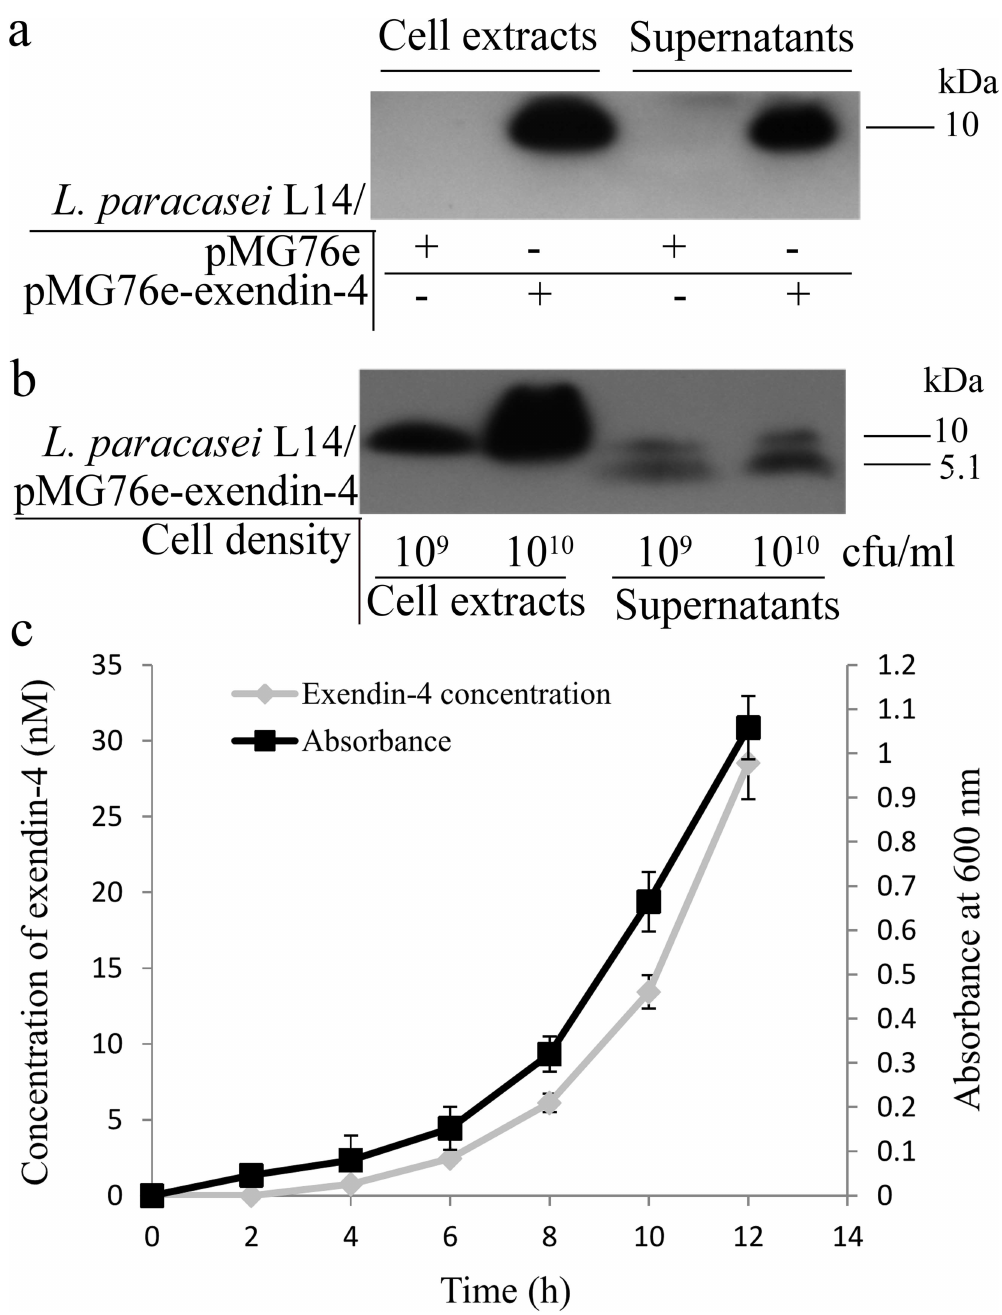
Fig 2. Western blotting and enzyme-linked immunosorbent assay (ELISA) analysis of recombinant exendin-4 produced by plasmid-transformed L . paracasei L14 strains. (a) Strains cultured in MRS medium: lanes 1 and 2, cell pellet of L . paracasei L14/pMG76e and L . paracasei L14/pMG76e-exendin-4 strains, respectively; lanes 3 and 4, excretion of L . paracasei L14/pMG76e and L . paracasei L14/pMG76e-exendin-4 strains, respectively. (b) Strains cultured in buffered RPMI 1640 medium: lanes 1 and 2, cell pellet extraction of L . paracasei L14/pMG76e-exendin-4 strain with bacterial concentration of 10 9 cfu/ml and 10 10 cfu/ml, respectively; lanes 3 and 4, cell excretion of L . paracasei L14/pMG76e-exendin-4strain with bacterial concentration of 10 9 cfu/ ml and 10 10 cfu/ml, respectively. (c) ELISA of exendin-4expression in vitro at different time points of culture as describedin the methods (three repeat expressions, means ±